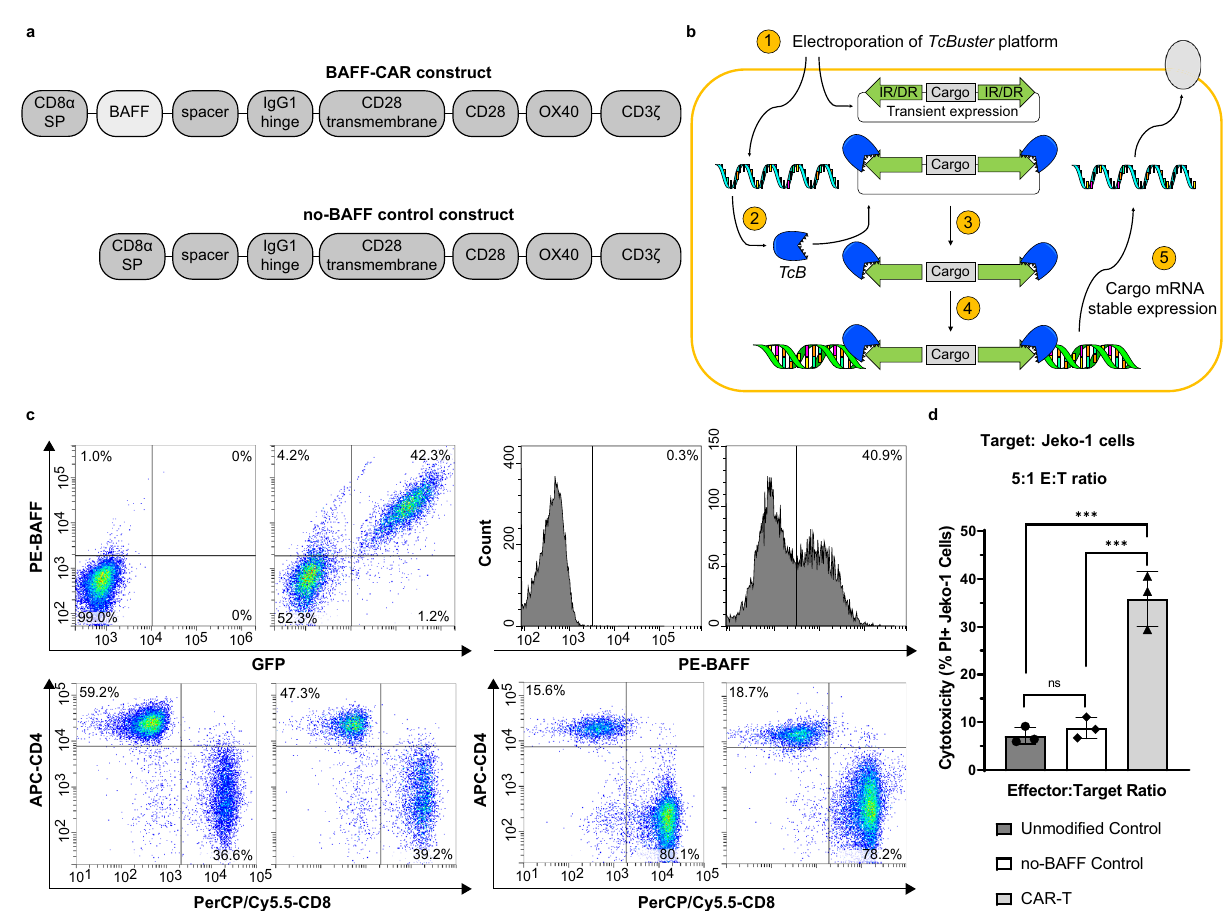
Fig. 1 CAR-T cells were produced using the BAFF-CAR construct via different expression methodologies. a Schematic of the BAFF-CAR construct, which consists of extracellular BAFF ligand, short spacer, hinge from human IgG1, CD28 transmembrane and signaling domains, OX40, and CD3 ζ . A construct lacking extracellular BAFF (no-BAFF) was used as a negative control. b Schematic of the non-viral TcBuster (TcB) transposon system, which enables stable expression of a CAR protein. 1. TcB transposase mRNA and transposon plasmid are introduced into the cell. 2. Protein from TcB mRNA is produced. 3. Transposase cuts the cargo from the transposon plasmid. 4. TcB transposase pastes the transposon cargo into the genomic DNA. 5. Cargo mRNA is transposase system. 5 days after lentiviral transduction, ef fi ciency of transduction was measured based on % GFP expression and correlated